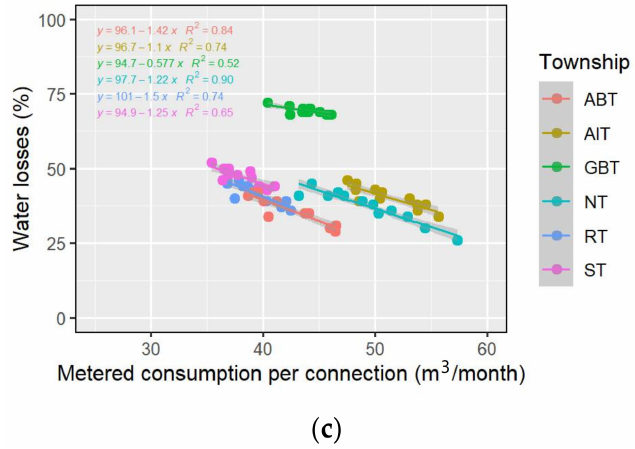
Figure 6. Water losses: ( a ) time-series of NRW and water loss in Tajpura; ( b ) NRW and water loss estimated by billed and metered consumption for the six townships in 2020; and ( c ) correlation between water losses and metered consumption per connection in the six townships.